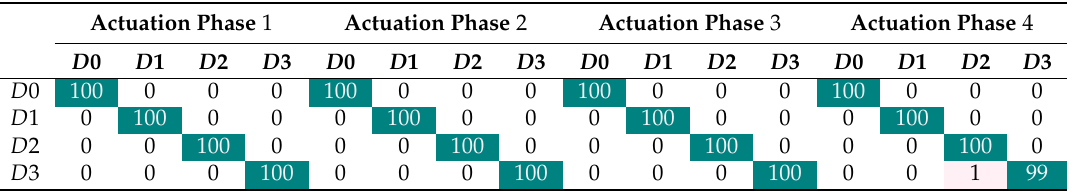
Table 3. Confusion matrix of the application of the t -SNE based damage detection and classification procedure presented in Sections 3 and 4 to the case of the aluminum plate in Scenario 2 , in the frequency domain . Rows represent true values, while columns represent predicted